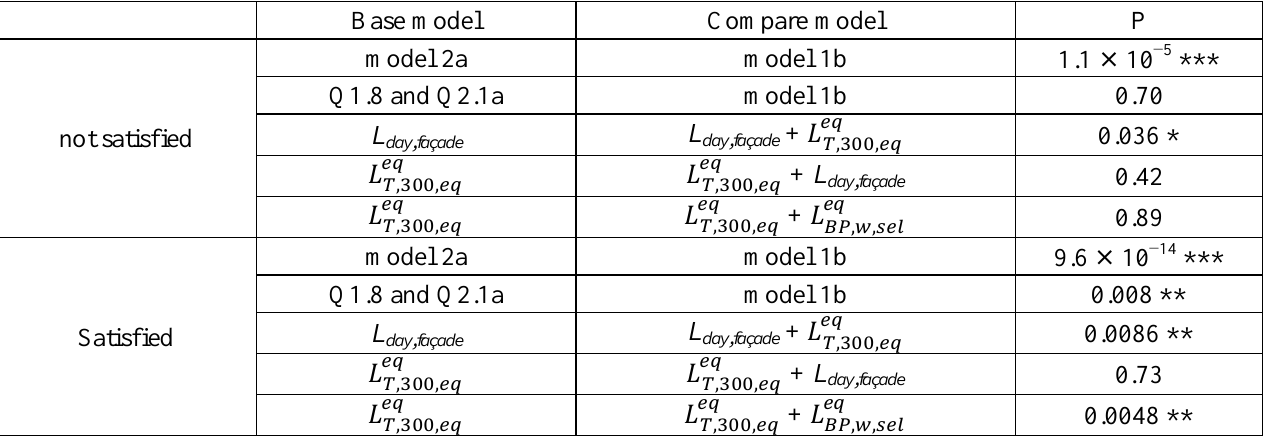
Table 6. p value in ANOVA chi squared test comparing different models for predicting satisfaction with quality of life in the neighborhood